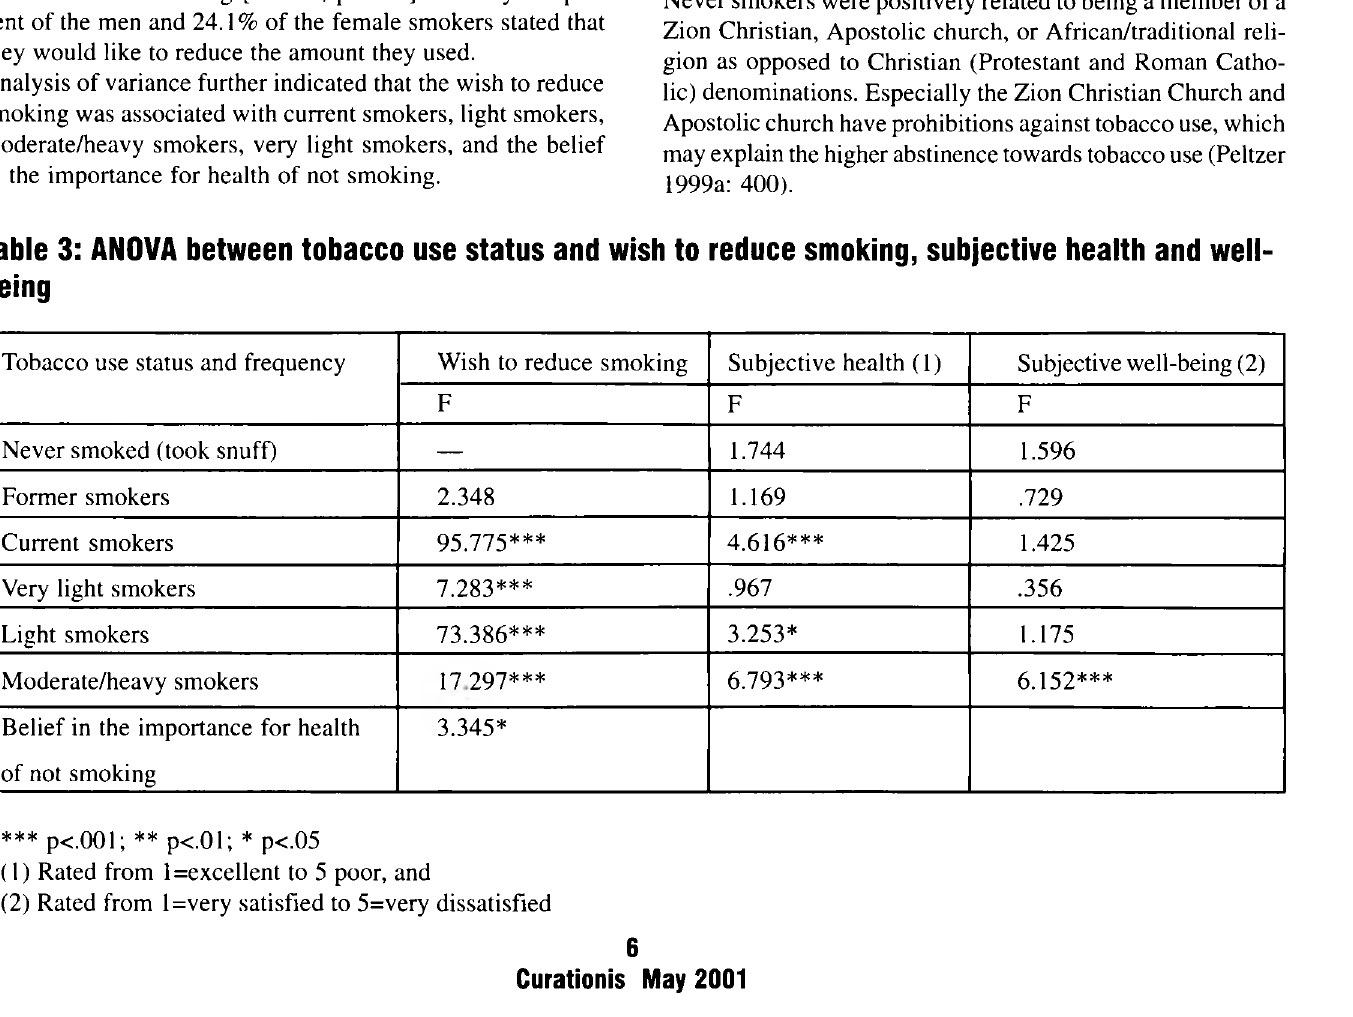
Table 3: ANOVA between tobacco use status and wish to reduce smoking, subjective health and well­